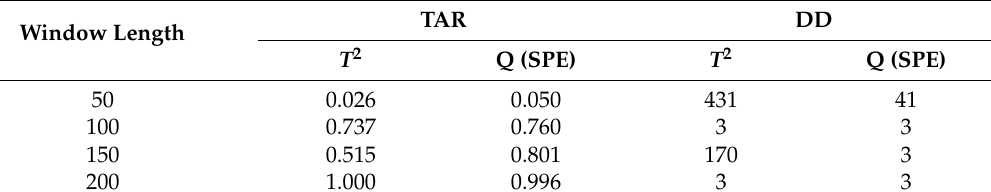
Table 7. Monitoring results on AG mill power draw using Method II.